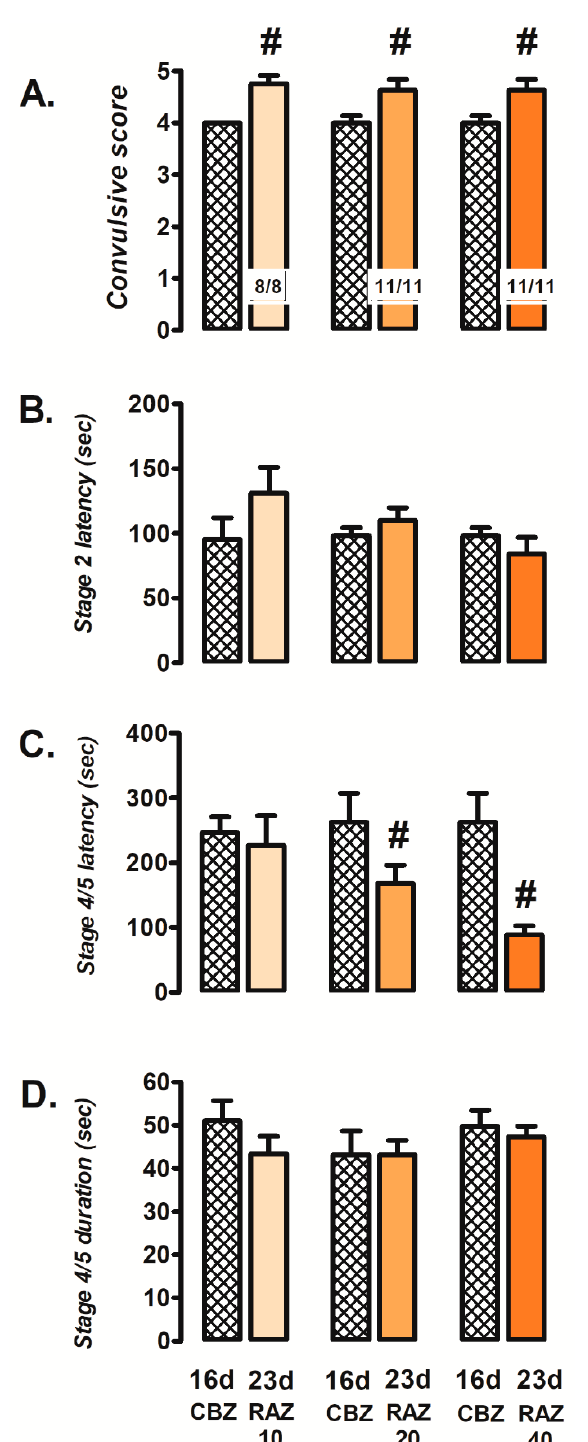
Figure 4. Effects of ranolazine (23 d; RAZ, 10, 20 or 40 mg/kg i.p.) on convulsive score ( A ), stage 2 latency ( B ), latency ( C ) and duration ( D ) of stage 4/5 convulsions. Data represent mean ± SEM. # p < 0.05, significantly different from the CBZ-resistant state (16 d). Carbamazepine (CBZ). Thus, with the exception of eslicarbazepine-300, sodium channel blockers had no anticonvulsant efficacy on CBZ-resistant animals.